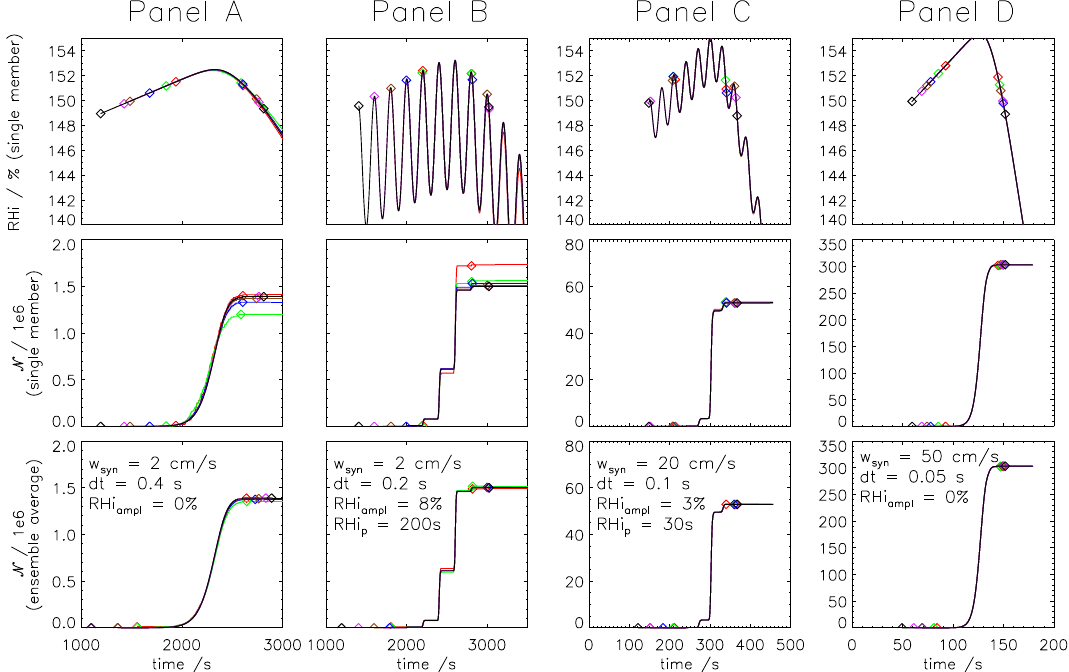
Fig. 10. LCM box model simulations with stochastic nucleation implementation, analogous to right column of Fig. 9 with temporal evolution of relative humidity RH i and ice crystal number N . The middle row shows ice crystal number for one individual box model simulation, the bottom row for an ensemble average of ten box model simulations with different random number seedings. The setups differ in terms of constant updraught speed w syn , time step ∆ t NUC and the optional superposition with small-scale temperature oscillations which are described in terms of amplitude RH i,ampl and wave period RH i,p of the induced RH i oscillations (see legend in each panel). Simulations for various minimal ice crystal numbers in a SIP ν min = n min V GB are depicted: 10000 (red), 5000 (green), 1000 (blue), 100 (brown), 10 (magenta) and 1 (black). The diamonds indicate the times the first and the last SIP are created. The plotting of relative humidity curve starts when the first SIP is created.